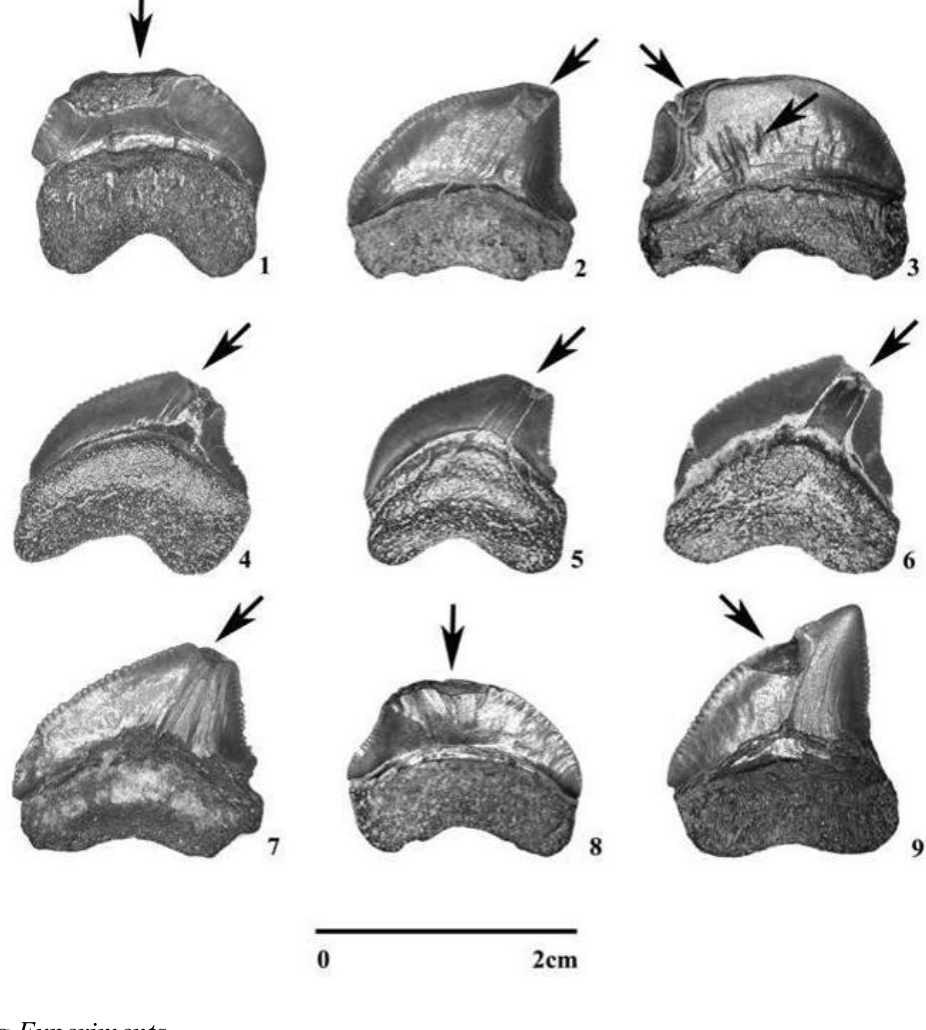
Figure 4. Feeding related damage in Squalicorax pristodontus teeth from the lowermost Navesink Formation, Monmouth County, New Jersey. Types A and B damage: 1 – 3 , 7 – 9 ; Types C and D damage: 4 – 6 . Scale bar: 1–9 = 2.0 cm. Tooth orientations: 1–3, 7–9